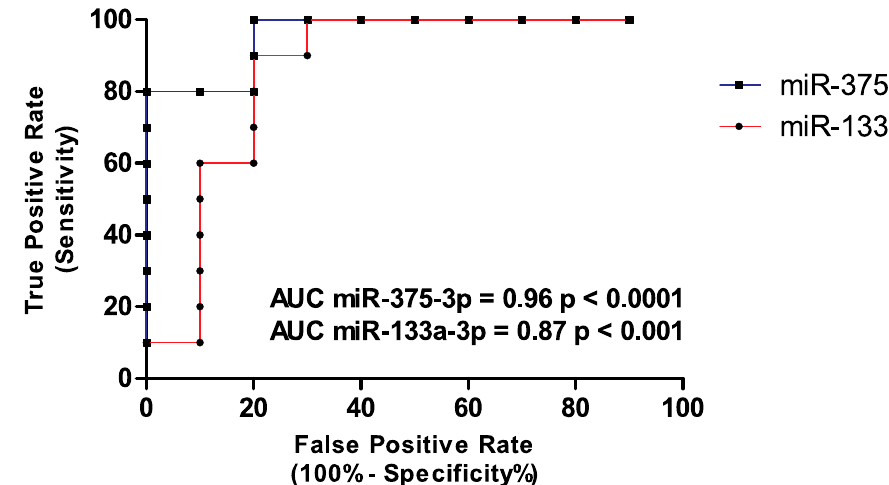
Figure 1. ( A ) Plasma levels of hsa-miR-133a-3p in oral cancer patients vs normal controls; ( B ) Plasma levels of hsa-miR-375-3p in oral cancer patients vs normal controls; ( C ) Plasma levels of hsa-miR-503-5p in oral cancer patients vs normal controls. Results are expressed as copies / µ L which means the number of copies of a target contained in 1 µ L of the 22 µ L reaction mix. ***: p < 0.001; ****: p < 0.0001; ns: no statistical significance.